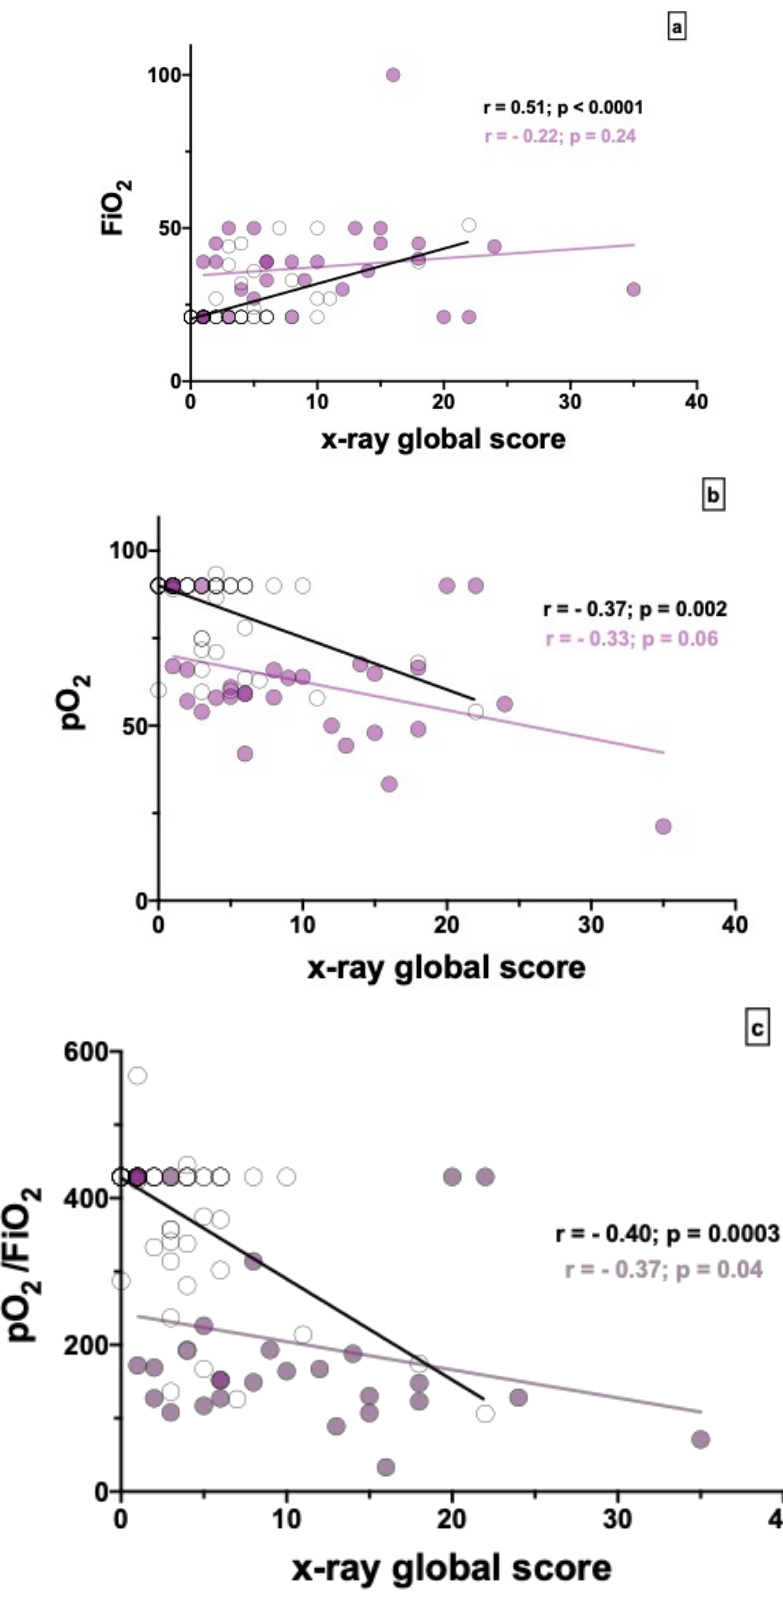
Figure 1. Correlation between chest x-ray global score and ( a ) FiO2 at admission, ( b ) pO 2 at admission in room air, and ( c ) pO 2 / FiO 2 at admission in room air in the study population categorized in LIMC and HIMC groups. Black points indicate LIMC patients and purple points indicate HIMC patients.